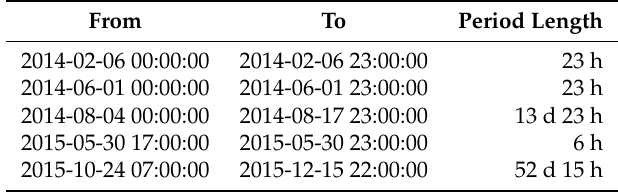
Table 3. Missing periods in the transits dataset with respective